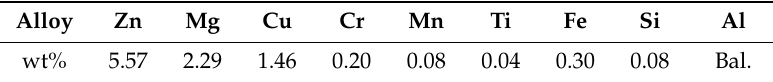
Table 1. Chemical composition of the AA7075